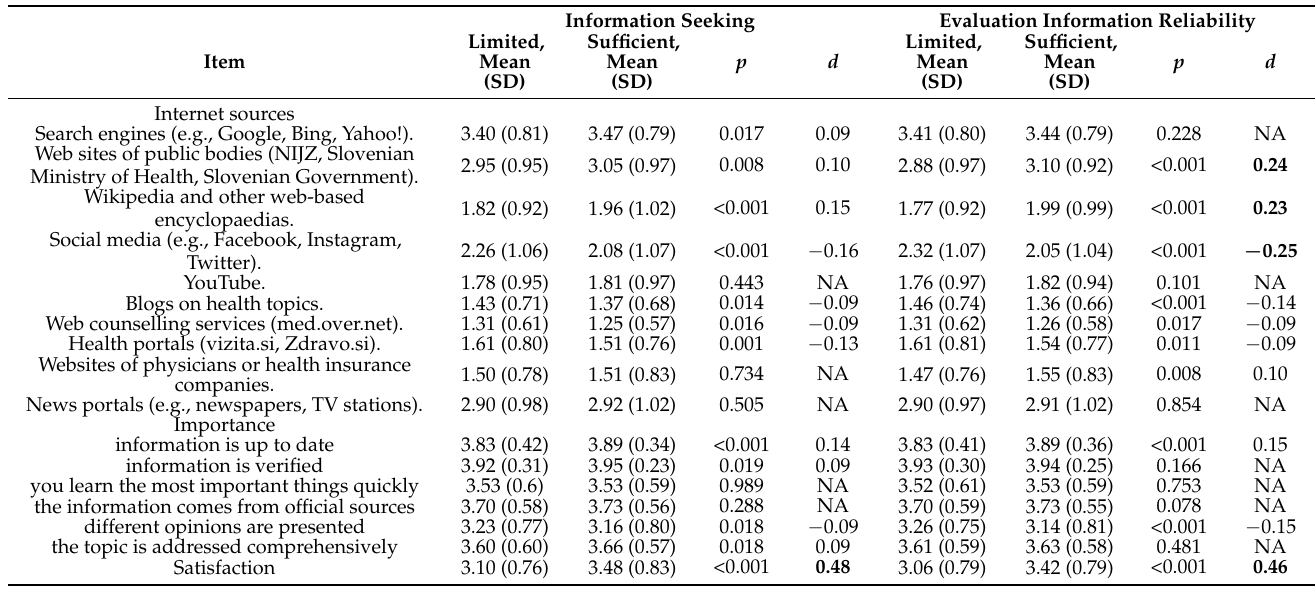
Table 4. DHL regarding the frequency of use, perceived importance, and information satisfaction. Information Seeking Evaluation Information